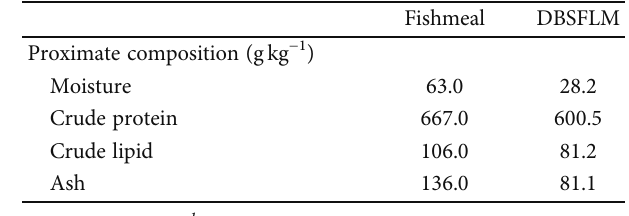
Table 1: Proximate and amino acid composition of fi shmeal and